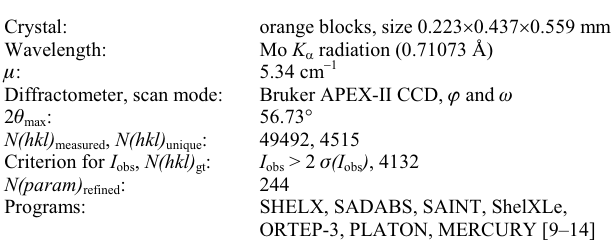
Table 1. Data collection and